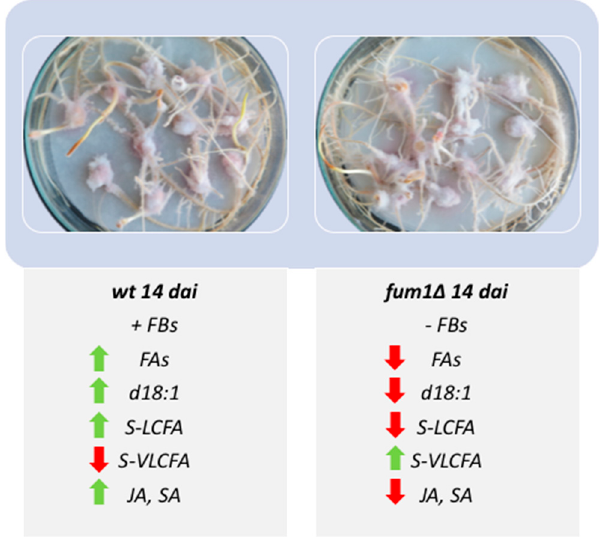
Figure 7. Seedlings infected at 14 dai with F. verticillioides wild-type (wt) or fum1 deletion mutant ( fum1 ∆ ) strains. Lipids, hormones, and genes are accompanied by the green or red arrow to indicate the relative increase or decrease.